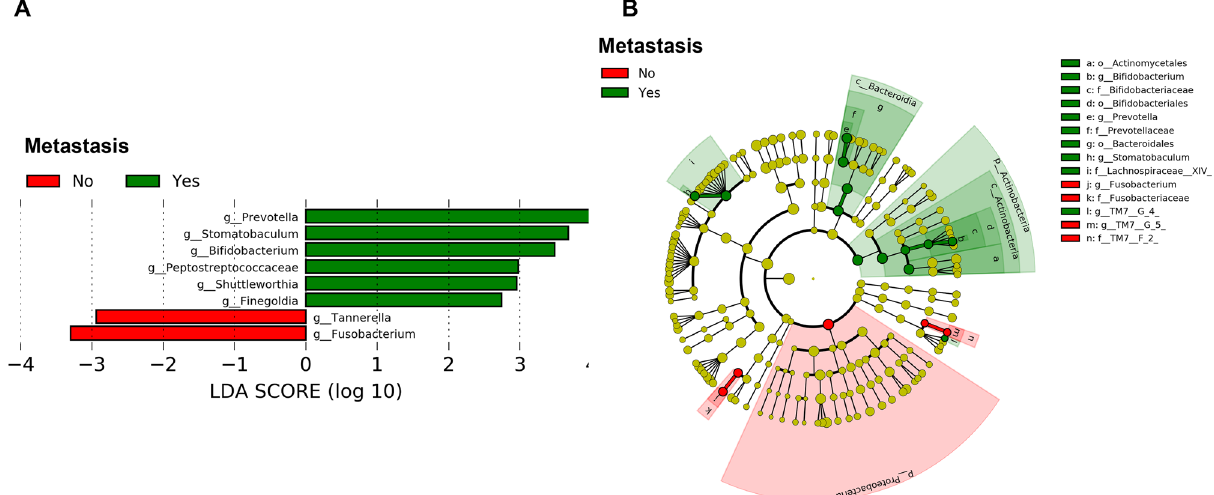
Figure 5. LDA effect size analysis showing differentially abundant taxa between patients with LNM and non- LNM with a threshold of |log10 LDA|≥ 2. Bar chart showing Log10 LDA of differential taxa in OSCC patients between metastasis and no metastasis groups ( A ). Cladogram showing the hierarchy among discriminative taxa. From phylum to genus, each node represents a taxonomic level. Red nodes demonstrate enriched taxa in the no metastasis group; green nodes represent enriched taxa in the metastasis group, LDA; linear discriminant analysis, OSCC; oral squamous cell